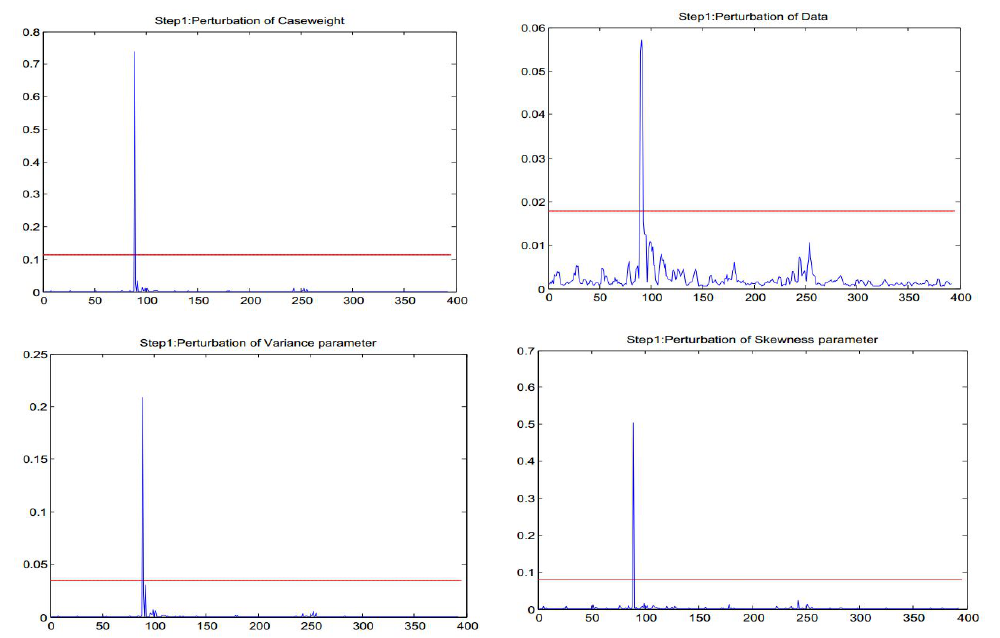
Figure 4. Diagnostics for the perturbations of case-weights, data, variance, and skewness in the SN AR(3) model [step